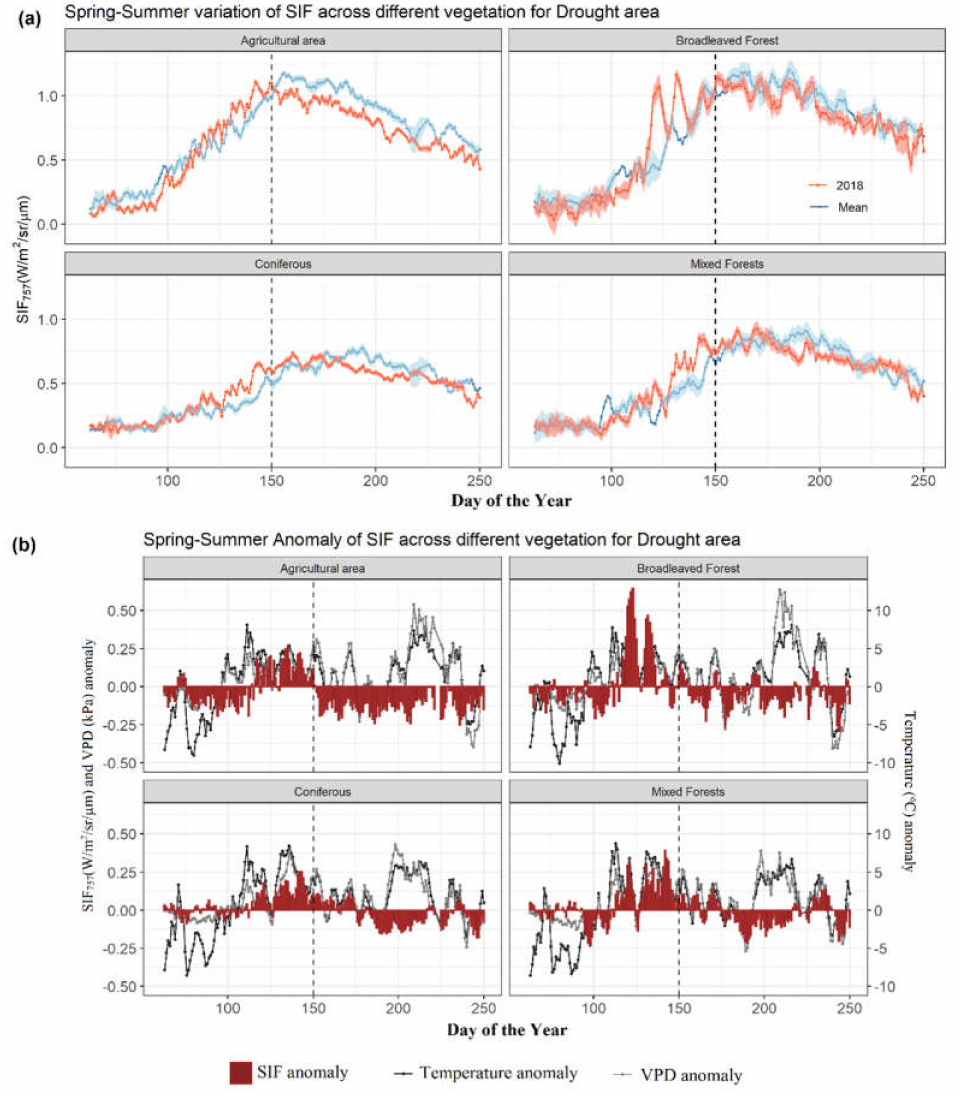
Figure 3. ( a ) Intra-seasonal SIF variability based on a 5-day running mean for drought areas across di ff erent vegetation types. ( b ) Corresponding SIF anomalies (SIF-Di ff ), and vapor pressure deficit (VPD) (gray line), and temperature (black line) anomalies. Positive values indicate a surplus of SIF, temperature (Temp), and VPD; negative values indicate lower values in comparison to the mean in 2015–2017. Shaded area (light blue for “Mean”; red for “2018”) in part ( a ) is ± standard error of mean obtained after spatially aggregating the samples. The vertical dashed lines divide the DOY into spring (DOY 60–150) and summer (DOY 151–245) season. Temp-Di ff = Temp_2018–Temp_Mean; VPD-Di ff =